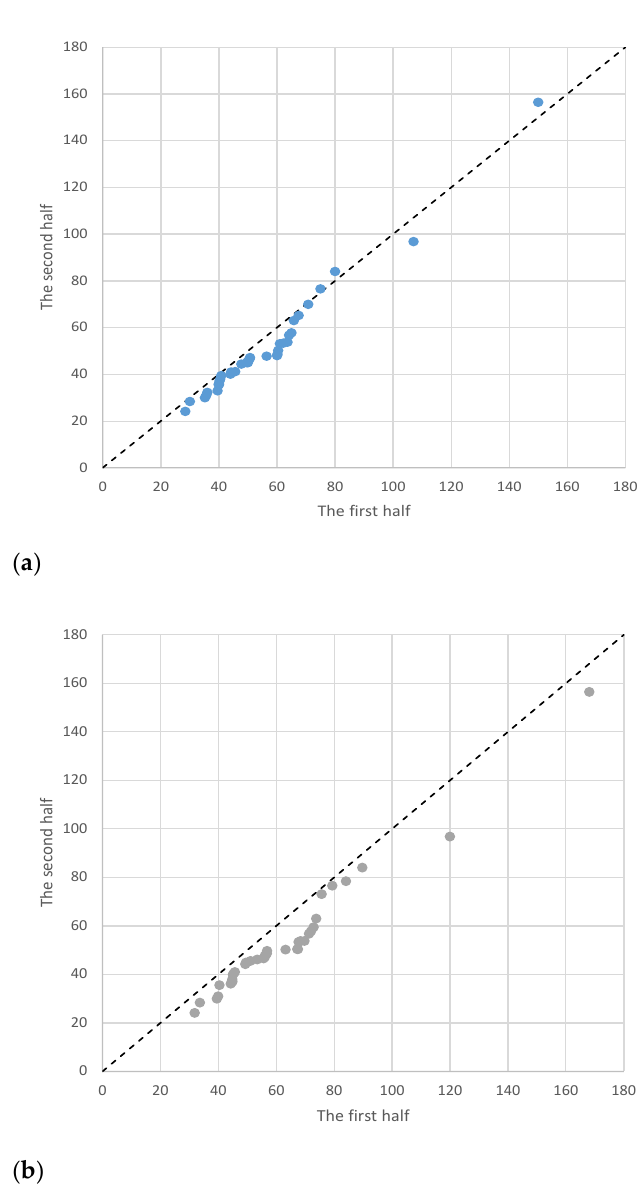
Figure 6. Trend conditions according to Sen’s method for the annual maximum rainfall depths for San Savino station and duration equal to 24 h: ( a ) “uncorrected” series; and ( b ) “corrected” series. Available data within the period 1921–2018.